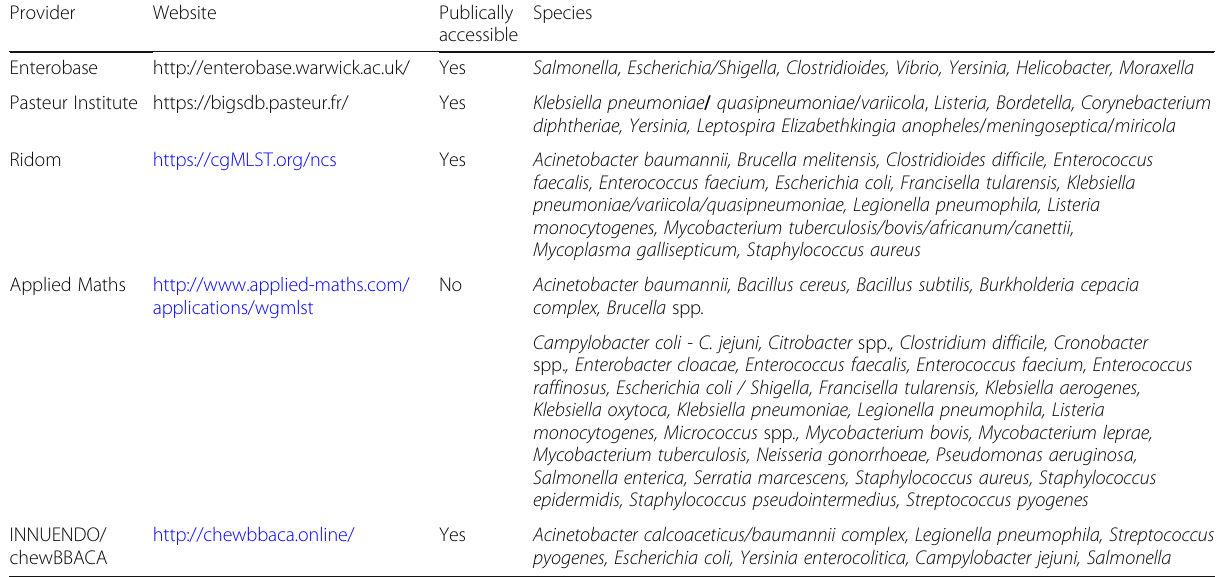
Table 2 Available cgMLST